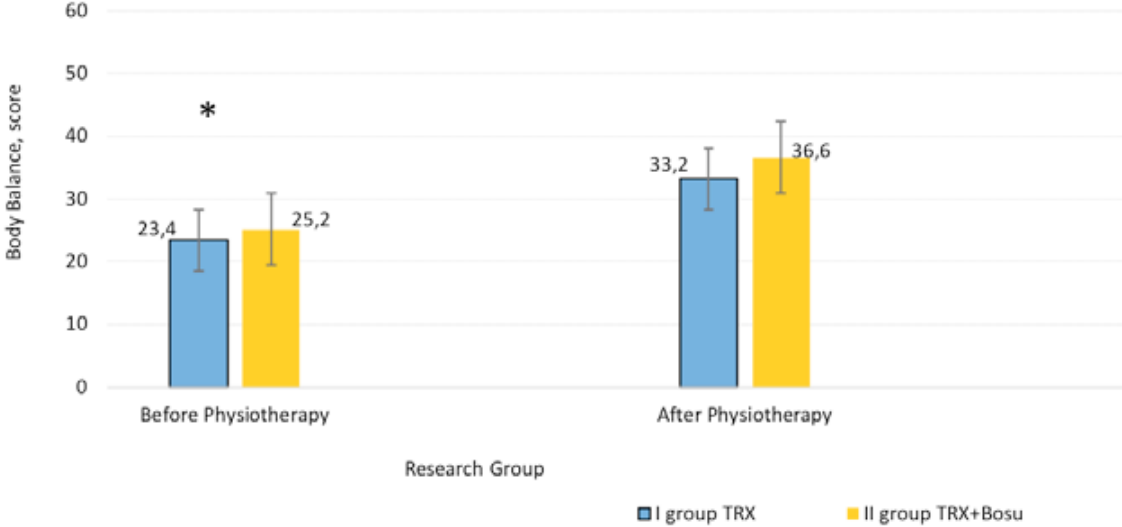
Fig. 3. Research subjects’ static and dynamic body balance assessment. Statistical significance, p<0.05